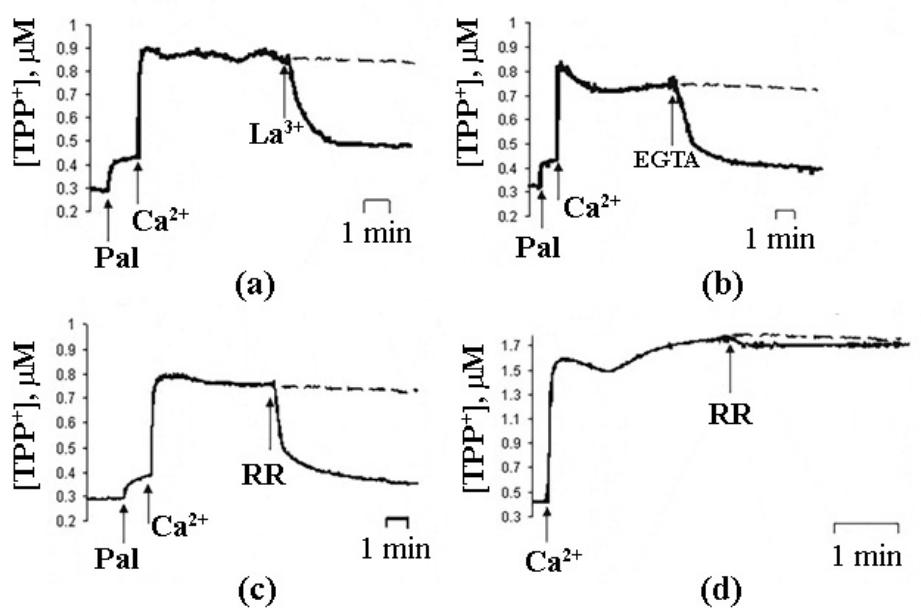
Figure 3. The effects of 5 µ M La 3+ ( a ), 1 mM EGTA ( b ), and 1 µ M ruthenium red (RR) ( c , d ) on the changes in ψ induced by the opening of PA-mPT ( a – c ) and mPT ( d ). The incubation medium constable 210 mM mannitol, 70 mM sucrose, 5 mM succinate, 5 µ M EGTA, 1 µ M rotenone, and 10 mM Hepes/KOH (pH 7.4). Additions in ( a – c ): Pal (30 nmol/mg protein), Ca 2+ (70 nmol/mg protein) and 1 µ M CsA; in ( d ): Ca 2+ (200 nmol/mg protein) and 1 mM Pi. Dashed line, control (without RR). Typical traces are shown ( n = 7). Adapted from Mironova et al. J. Bioenerg. Biomembr. 39 (2007): 167–174,